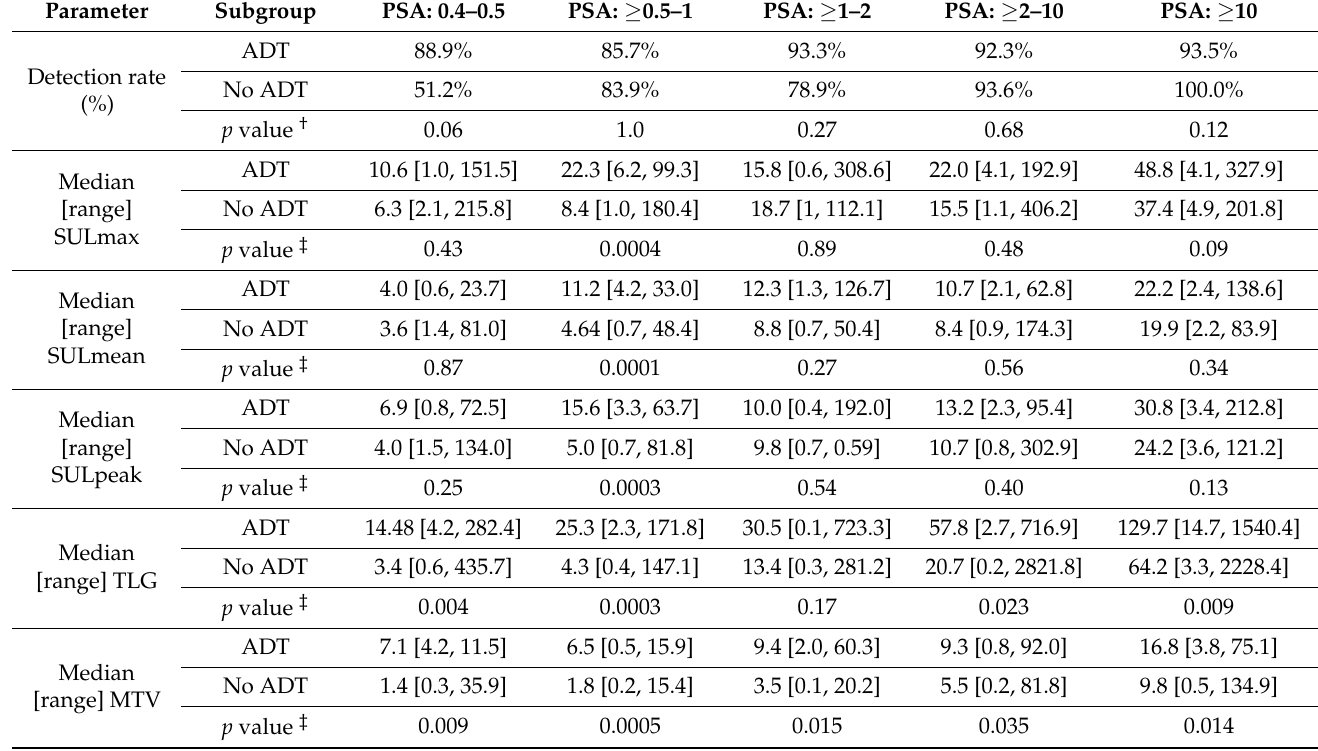
Table 2. [ 18 F]DCFPyL PET/CT detection rates and the sum of the five most active lesions’ quantitative parameters in different PSA subgroups in patients with/without ongoing ADT at the time of